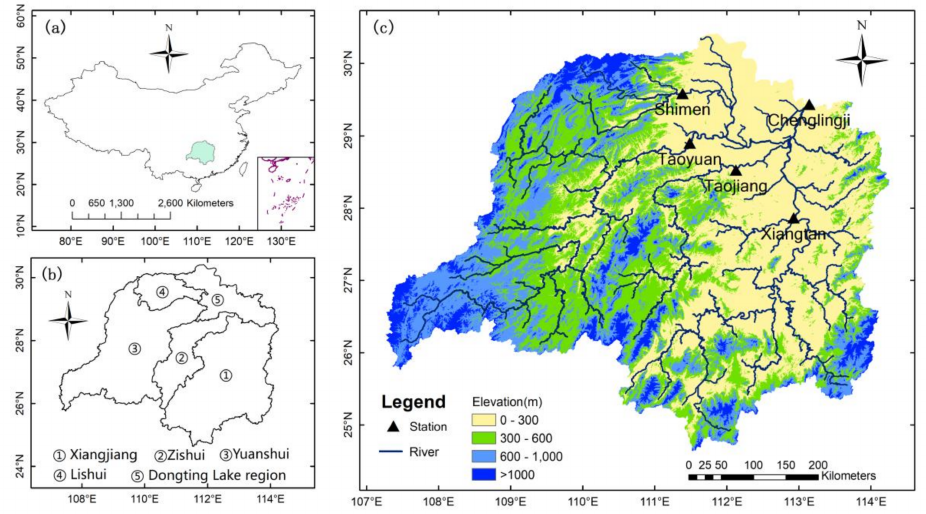
Figure 2. ( a ) location of Dongting Lake basin in central south China; ( b ) composition of the Lake basin and ( c ) the distribution of five hydrological